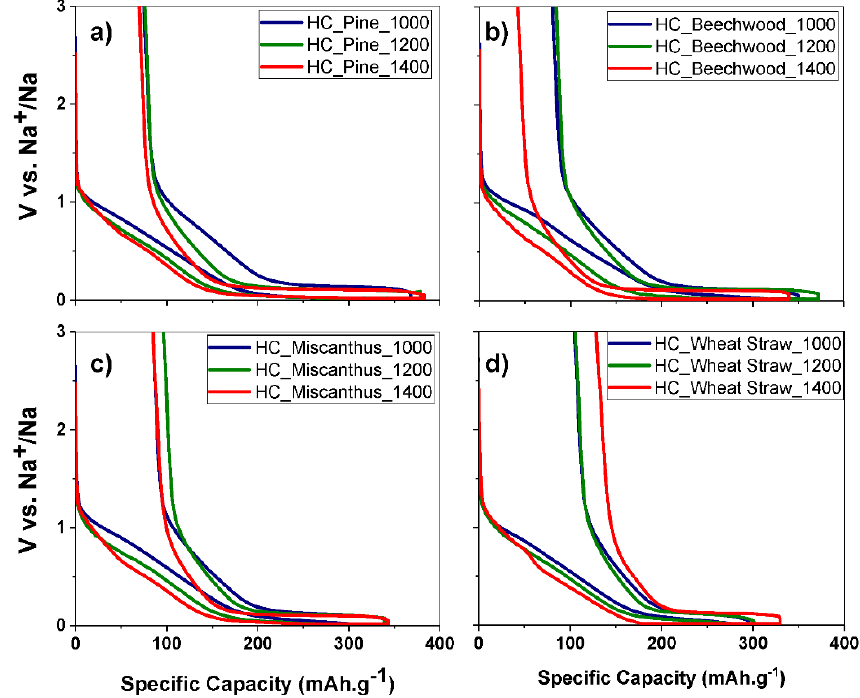
Figure 8. First cycle reduction–oxidation profiles for ( a ) pine, ( b ) beechwood, ( c ) miscanthus and ( d ) wheat straw derived hard carbons.